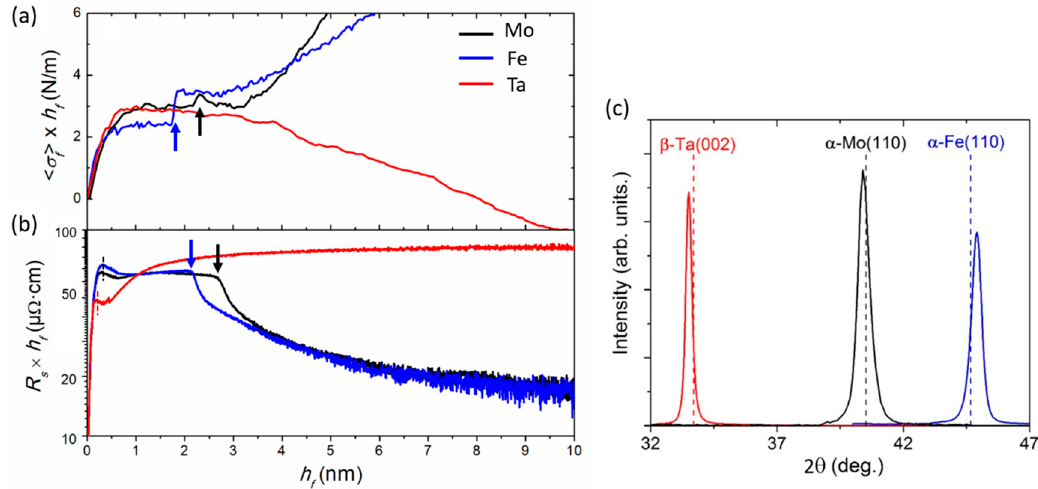
(cid:68) (cid:69) σ × h × h Figure 10. Real-time evolution of ( a ) Figure 10. Real-time evolution of ( a ) 〈𝜎 (cid:3033) 〉 × ℎ (cid:3033) and ( b ) 𝑅 (cid:3046) × ℎ (cid:3033) curves vs. film thickness ℎ (cid:3033) during f f and ( b ) R s f curves vs. film thickness h f during the early growth stages of Fe, Mo, and Ta films on a-Si at T = 300 K (deposition conditions are indicated in the early growth stages of Fe, Mo, and Ta films on a-Si at T = 300 K (deposition conditions are indicated Table 2). The arrows in ( a ) and ( b ) indicate the onset of film crystallization for Fe and Mo. ( c ) XRD in Table 2). The arrows in ( a ) and ( b ) indicate the onset of film crystallization for Fe and Mo. ( c ) XRD patterns recorded in Bragg–Brentano configuration from ~60 nm thick Fe, Mo, and Ta films using Cu patterns recorded in Bragg–Brentano configuration from ~60 nm thick Fe, Mo, and Ta films using Cu K α radiation ( λ = 0.15418 nm). MOSS data are taken from K α radiation ( λ = 0.15418 nm). MOSS data are taken from [105,128,134].